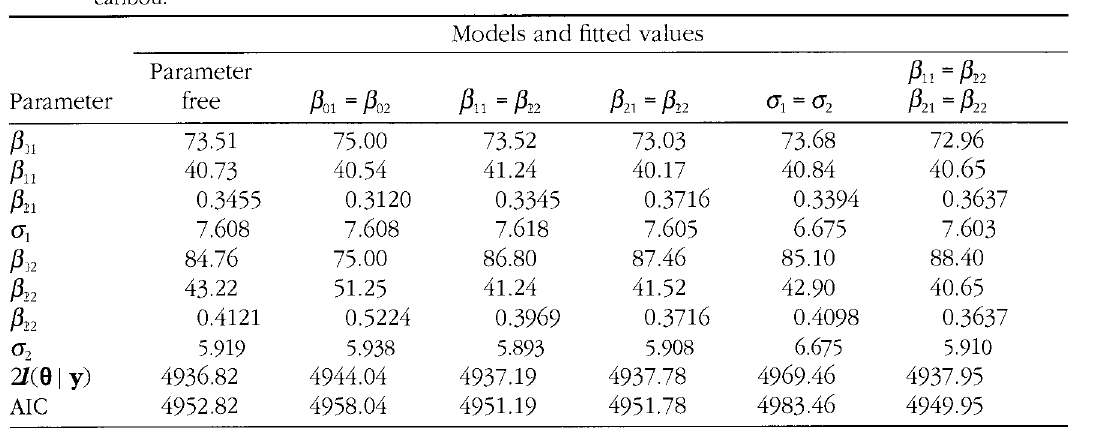
Table 2. Models and fitted values for parameters of growth curves of diastema length of Western Arctic Herd caribou.